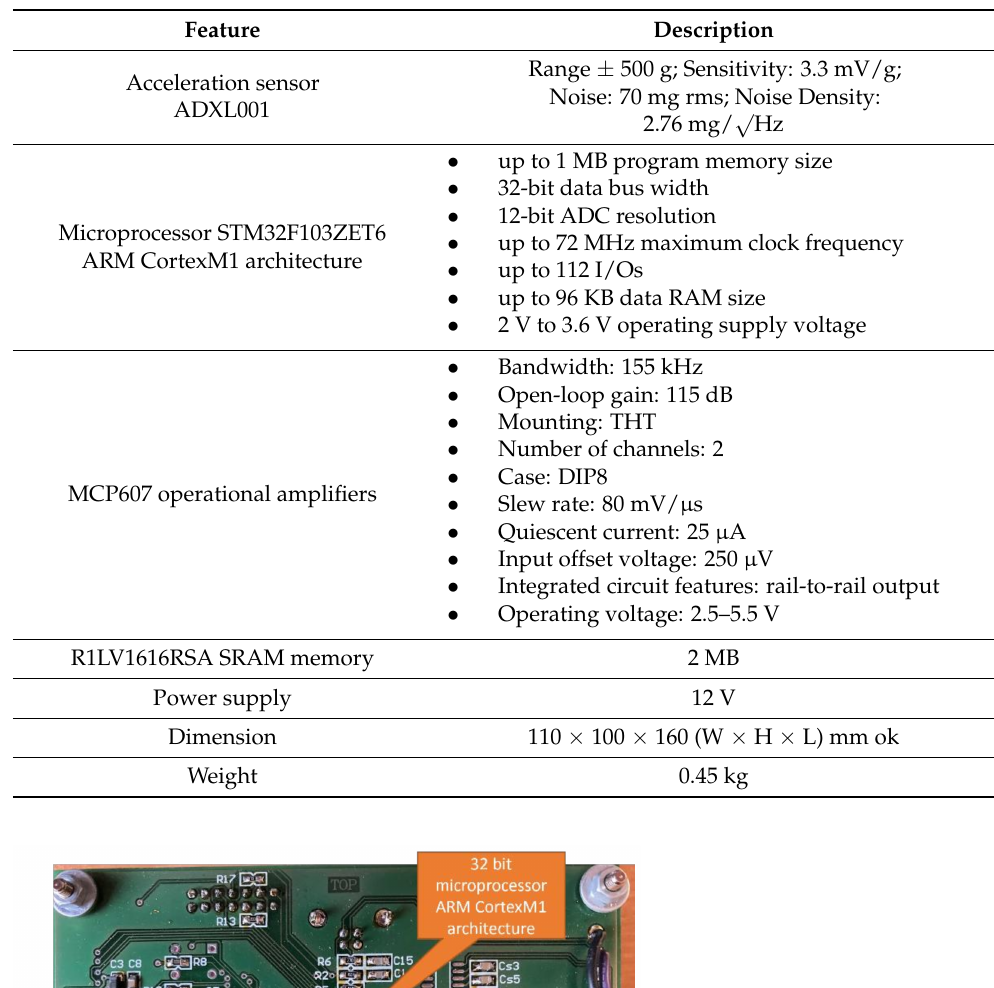
Table 1. Device specifications.